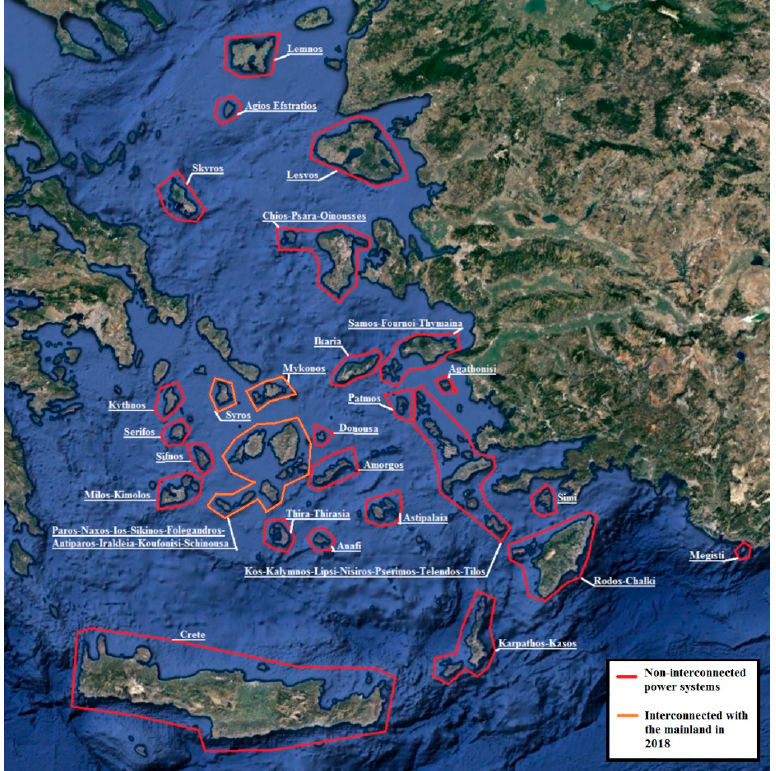
Figure 1. Overview of non-interconnected power systems in the Aegean Sea.